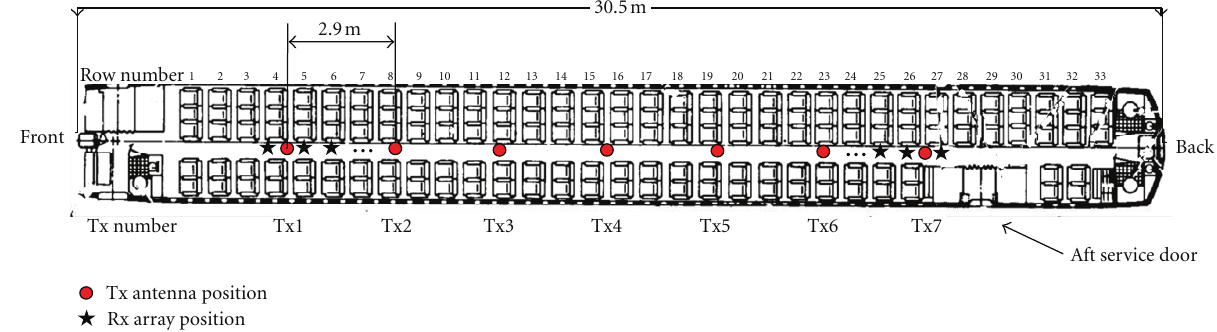
Figure 1: Interior arrangement of the measurement environment.